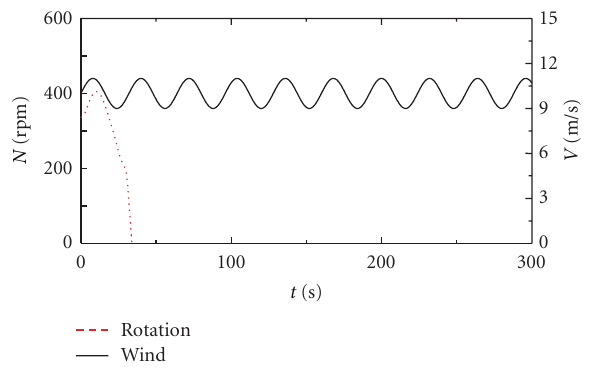
Figure 26: Time profile of rotational speed of pulsating wind in the case where V 0 = 10m/s, T = 32 s, and I = 3kgm 2 .